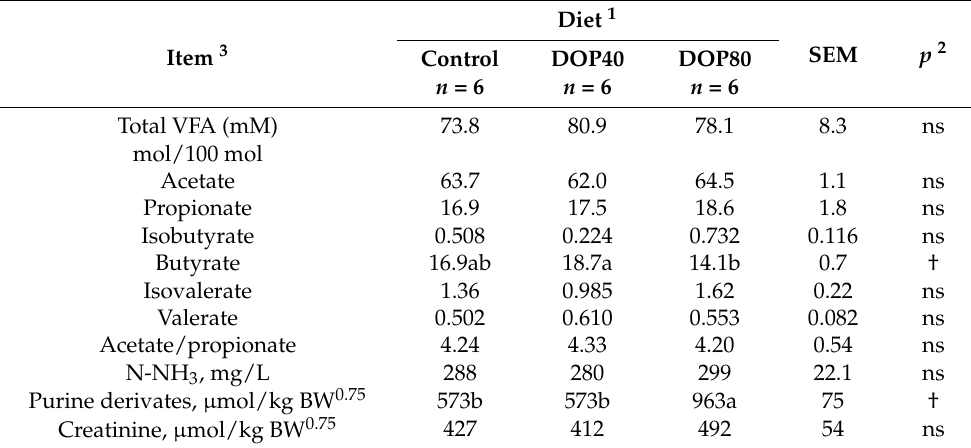
Table 4. Effects of experimental diets 1 on the rumen fermentation parameters and purine derivates in urine.